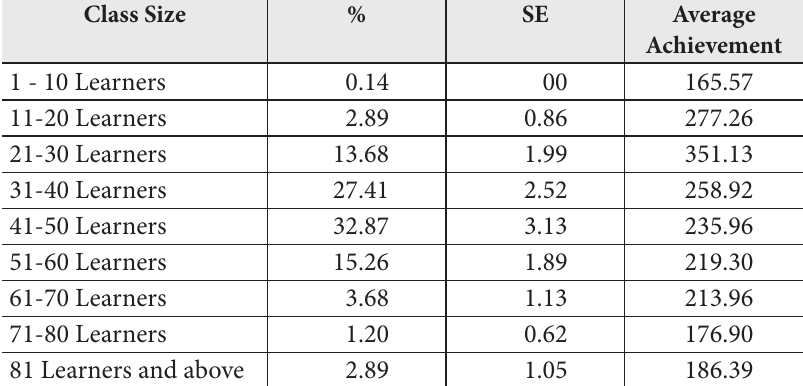
Table 2: Overall average achievement in comparison to class